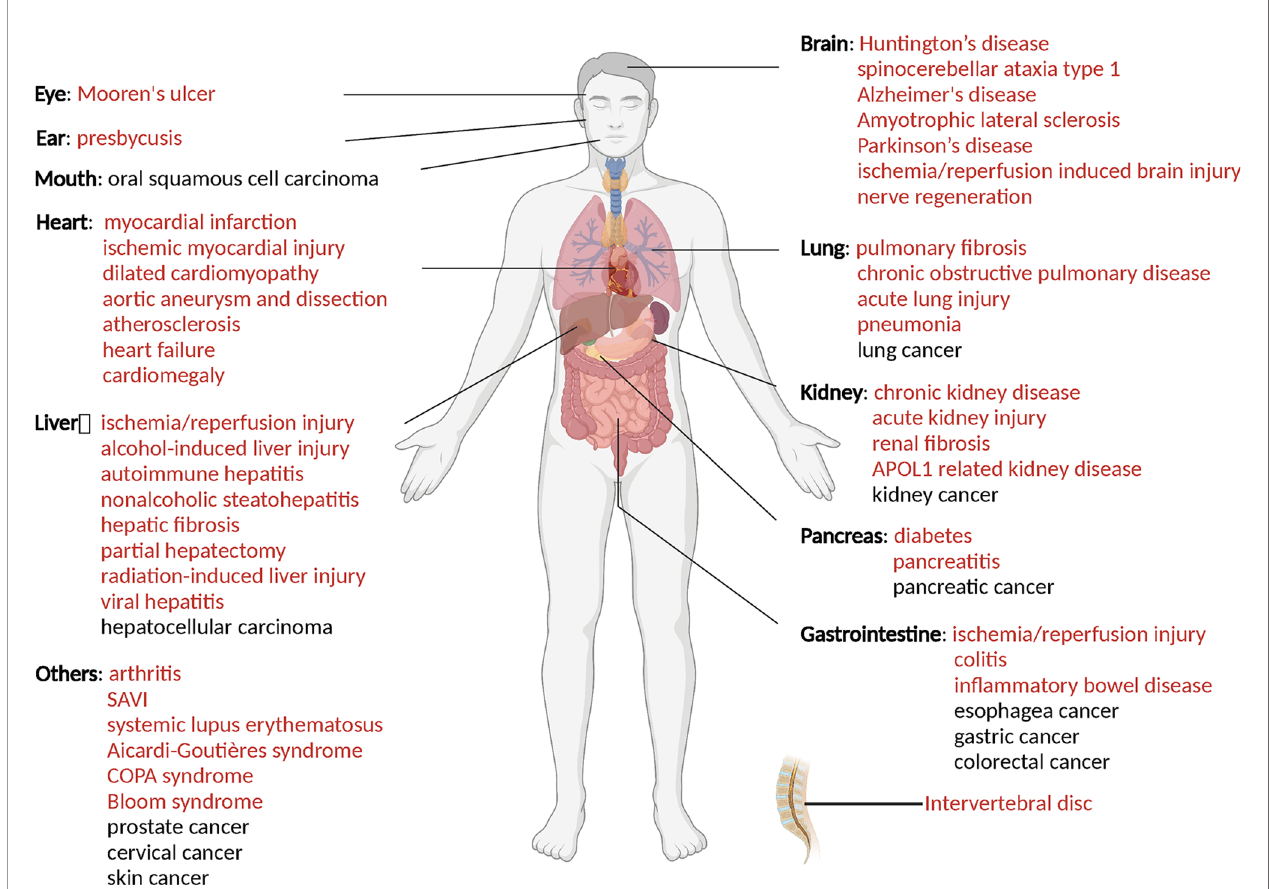
FIGURE 3 | STING related diseases. Red indicates diseases caused by over-activation of STING, while black indicates disease with low-activation of STING. This fi gure is created with